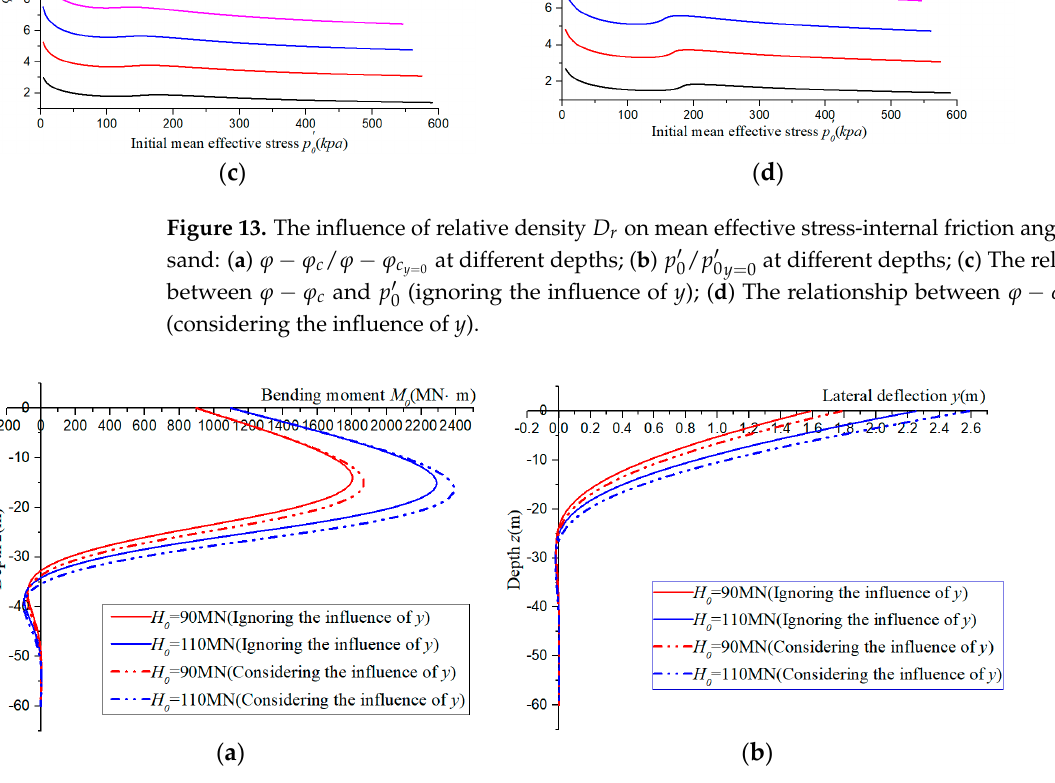
Figure 14. In fl uence of the sand state considering lateral de fl ection 𝑦 on the pile lateral characteris- Figure 14. Influence of the sand state considering lateral deflection y on the pile lateral characteristic: tic. ( a ) Curve of bending moment of pile versus depth; ( b ) Curve of lateral deflection of pile versus